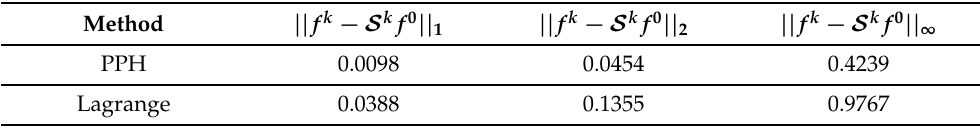
Figure 2. Comparison of the subdivision curve after k = 5 subdivision levels for the Lagrange subdivision scheme in a dashed red line and the PPH subdivision scheme in a dash-dotted black line. The original function is also plotted in a solid blue line. The initial control points, plotted with red circles, come from one of the nonuniform grids X considered in our two experiments, the one that consists of 20 abscissas in the interval [ 0,1 ] . ( Left ) Subdivision curve for data coming from f ( x ) . ( Right ) Subdivision curve for data coming from g ( x ) . Table 4. Subdivision errors || f k − S k f 0 || p , p = 1,2, ∞ , committed by approximating the original data f k with S k f 0 for k = 5 subdivision levels starting from the initial function point values f 0 at the given grid X 1 with 30